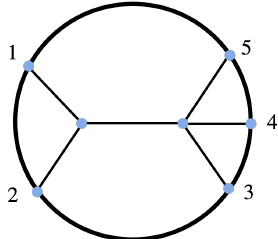
Figure 6 . The exchange Witten diagram with one bound state can be obtained from a five-point exchange Witten diagram by taking a coincidence limit where x